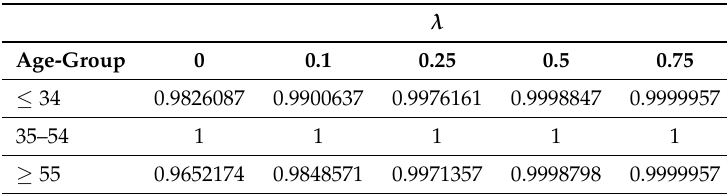
Table A5. Global stability measures for Spaniards’ preferences attending to different age ranges and several values of λ for Question 1.